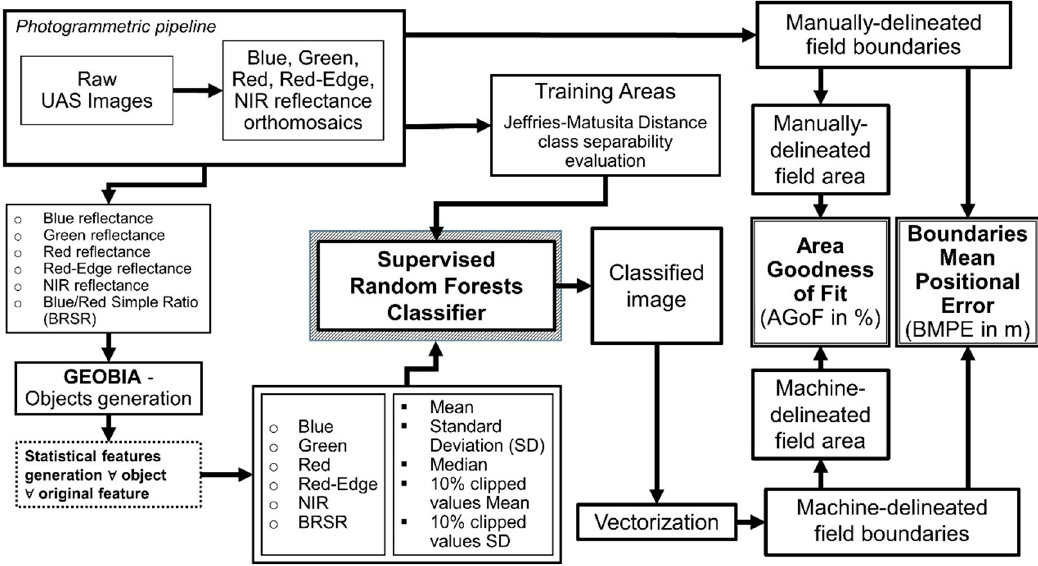
Figure 3. Flowchart of the Geographic Object-Based Image Analysis (GEOBIA) methodology.